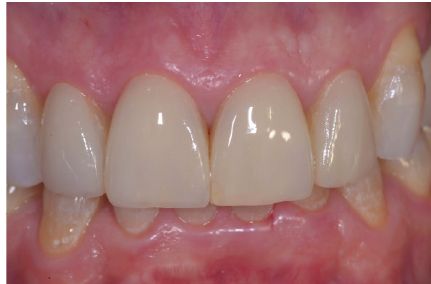
Figure 17: Postoperative intraoral